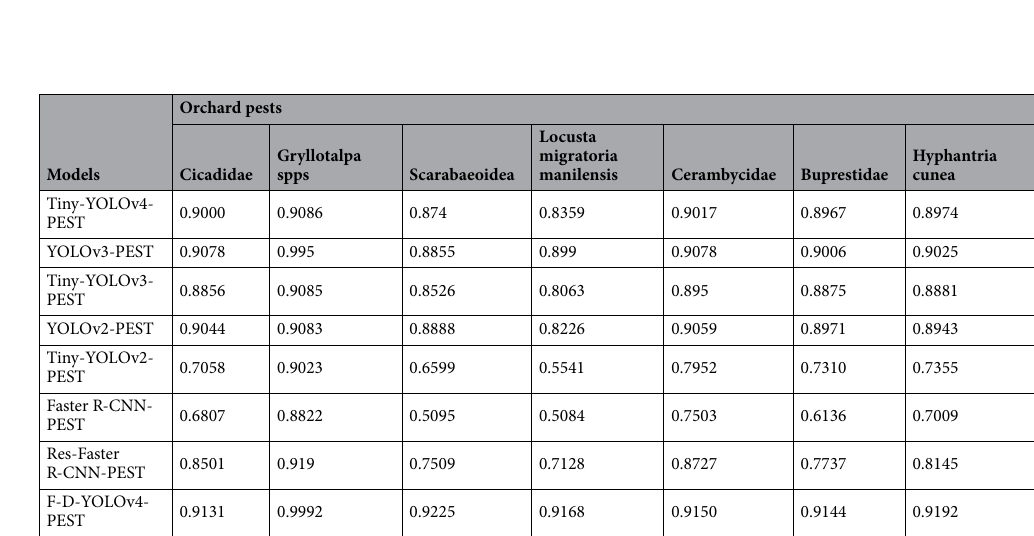
Table 10. The category detection AP of each model (IoU = 0.5).